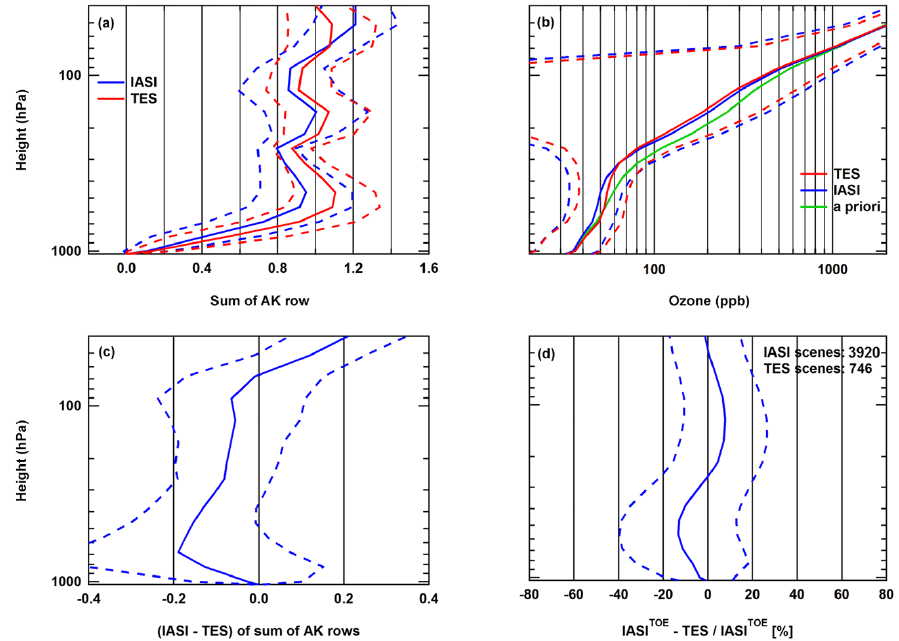
Figure 1. Ozone profiles (b) and vertical sensitivities (a) for TES and IASI-TOE, respectively. Also shown are the differences between TES and IASI (c, d) . Solid lines are the mean values and dashed lines the standard deviations.